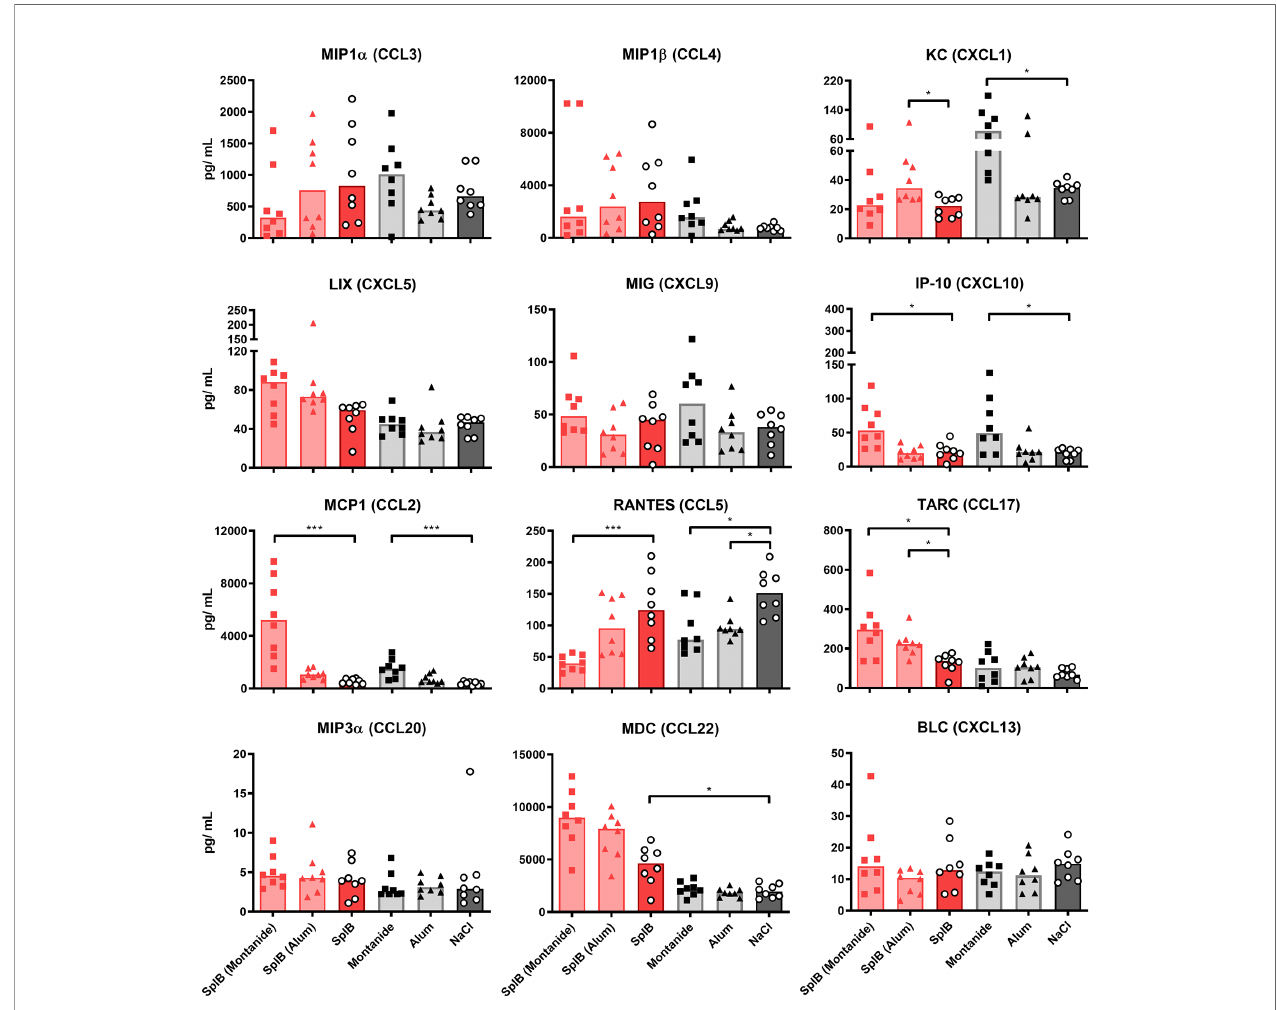
FIGURE 6 | Montanide-adjuvanted SplB-animals produced more IP-10, MCP1 and TARC. Isolated splenocytes were restimulated with SplB for 4 days, afterward the supernatant was harvested and the concentration of produced chemokines was measured via the LEGENDplex ™ Mouse Proin fl ammatory Chemokine Panel (13-plex). Data are presented as median. n = 8 animals per group. *p < 0.05; ***p < 0.001. Group comparisons that are de fi ned in the “ Statistical analysis ” section but not shown here are not signi fi